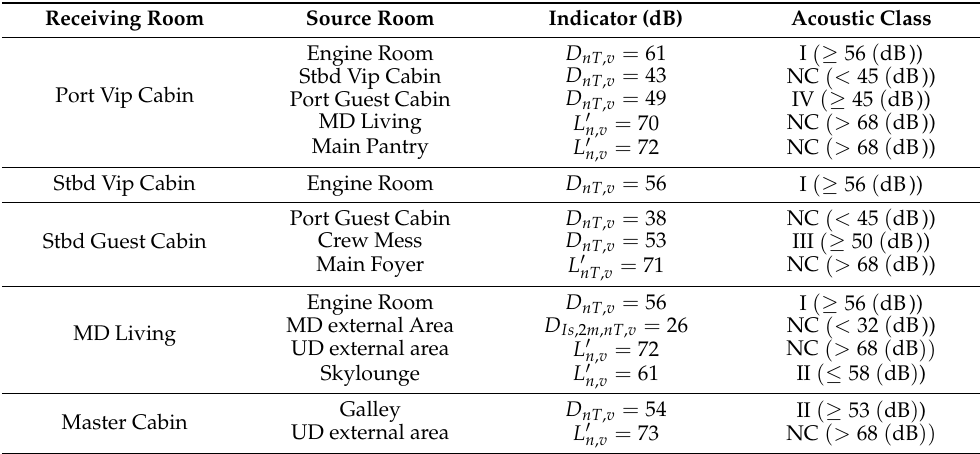
Figure 3. Reverberation time of the different rooms. Table 5. Acoustic performance indicators for the different rooms. Table 6. Ship’s compartment acoustic evaluation indicators.